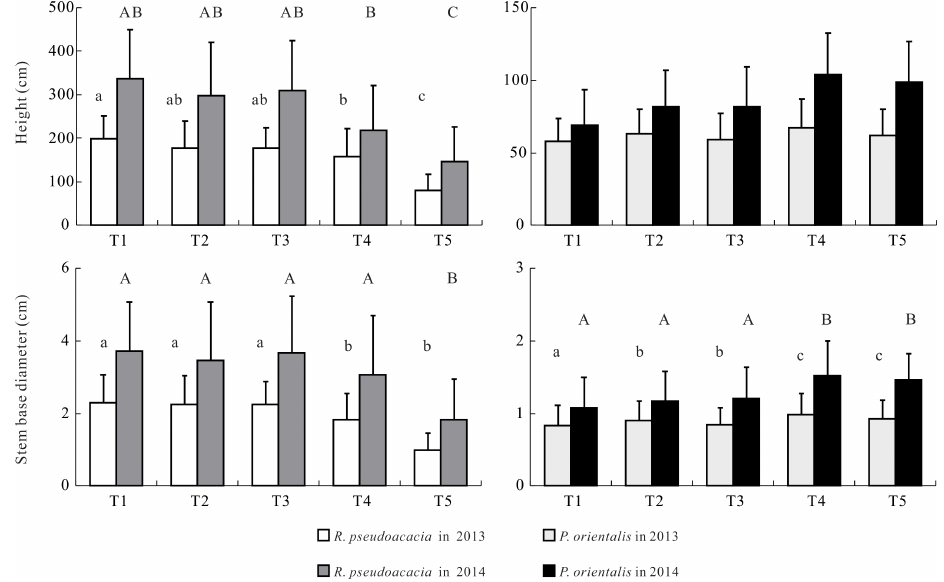
Figure 3. Wood growth. Note: the same lower-case or capital letter indicates that in 2013 or 2014 the difference between different compacted plots is not significant at the 0.05 level.